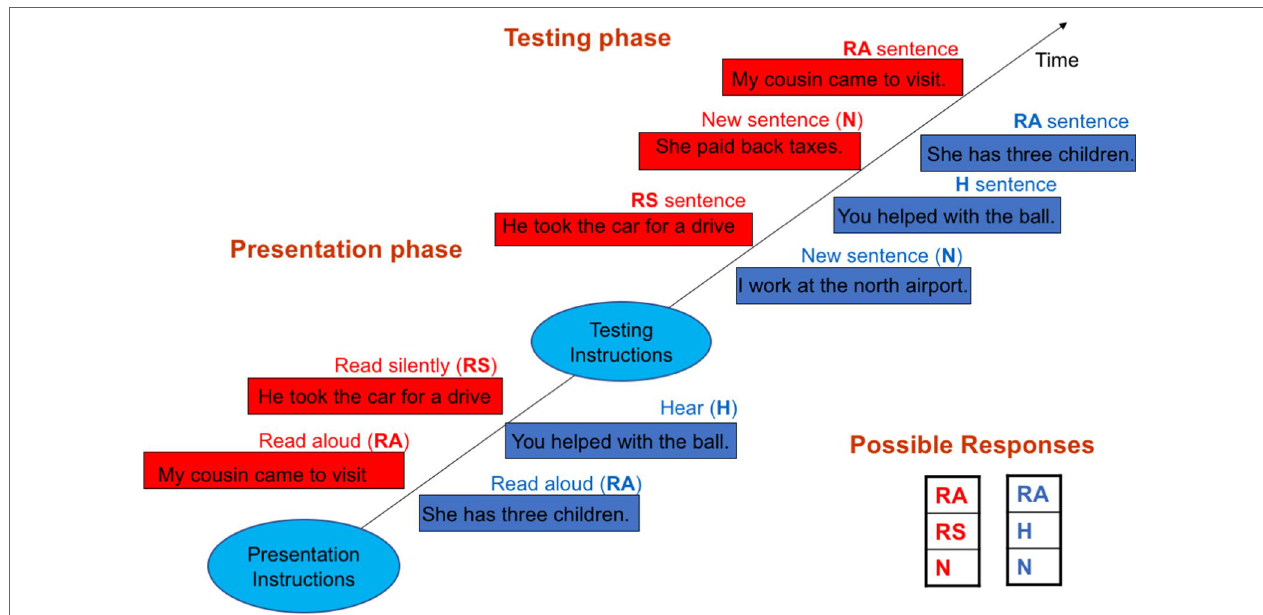
FIGURE 1 | Outlines of the self/other (S/O)—blue rectangles—and internal space/external space (IS/ES) distinction tasks—red rectangles. In the S/O task during the presentation phase, subjects alternately read aloud (RA) sentences appearing on the screen and heard (H) pre-recorded sentences played back while the screen remained blank. In the testing phase, the RA and H sentences were visually presented along with new (N) sentences one a time in random orders. Subjects were instructed to identify through button press the sentence type: RA, H or N. The IS/ES task followed the same general design. However, in the presentation phase, subjects instead alternately read aloud (RA) and read silently (RS) sentences visually presented on the screen. In the testing phase, the RA and RS sentences were visually presented along with new sentences (N), and subjects were instructed to identify the sentence type: RA, RS or